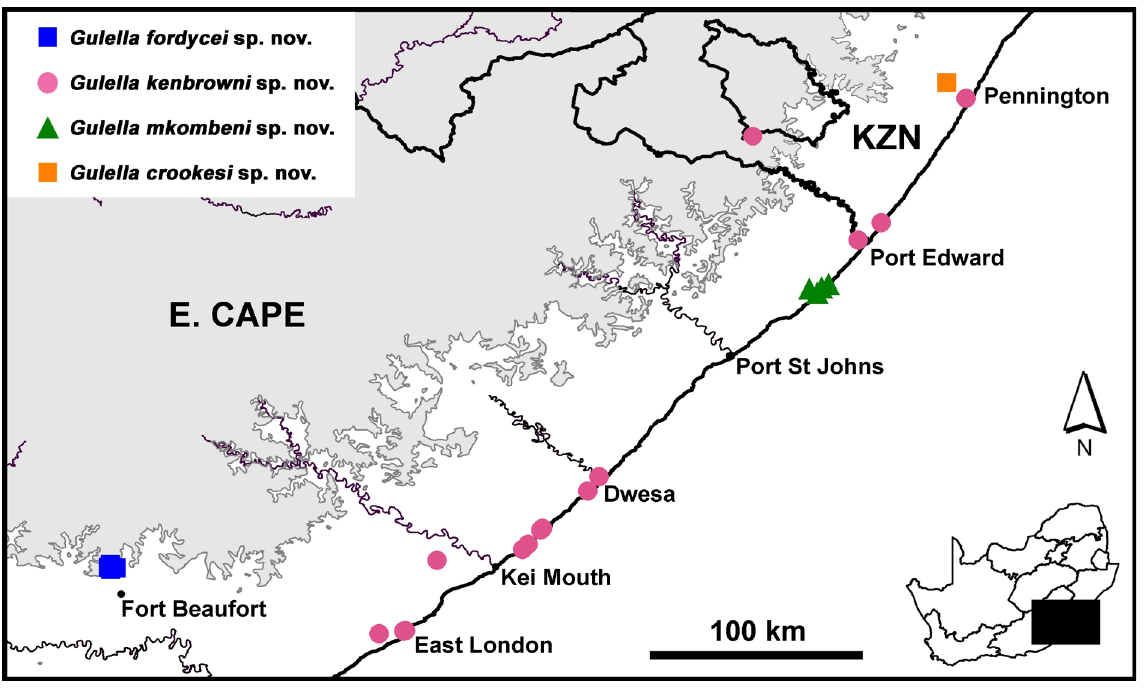
Fig. 2. Distribution map of Gulella kenbrowni sp. nov. (pink circles), G. fordycei sp. nov. (blue squares), G. mkombeni sp. nov. (green triangles) and G. crookesi sp. nov. (orange square). Contour at 1000